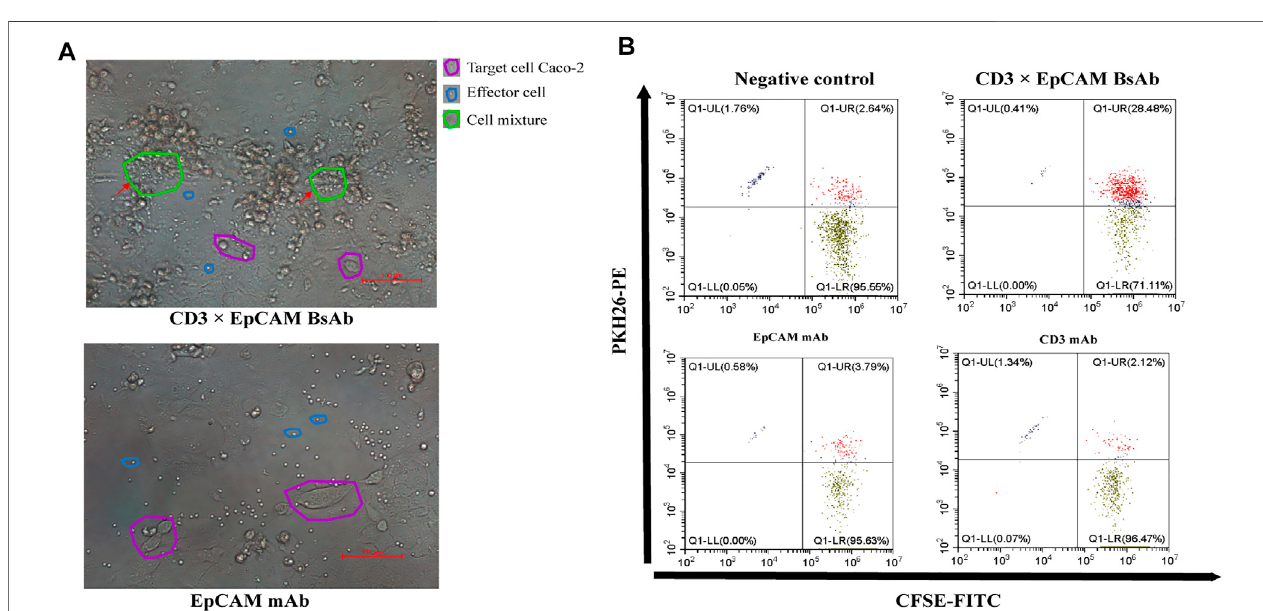
FIGURE 4 | T cell recruitment mediated by CD3×EpCAM BsAb. (A) The recruitment of T cells to tumor cells mediated by 150 ng/ml CD3×EpCAM BsAb and EpCAM mAb at an E: Tratioof 10:1 after an incubation of 24 h. Imageswere obtained under 20 × magni fi cation, and scale bars 100 μ m. (B) The recruitmentanalysisof CD3 + cells to tumor cells by CD3×EpCAM BsAb by fl ow